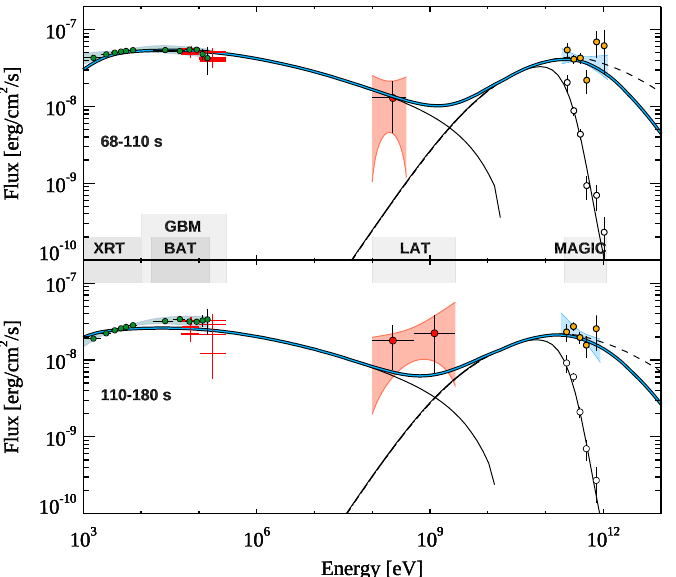
Figure 9. Synchrotron and SSC modeling of the broadband spectra of GRB 190114C in the two time intervals 68–110 s and 110–180 s. Dashed lines represent the SSC emission in the hypothesis of negligible internal γ − γ opacity. MAGIC points in the VHE band are reported with (empty circles) and without (filled circles) correction for the EBL absorption. From